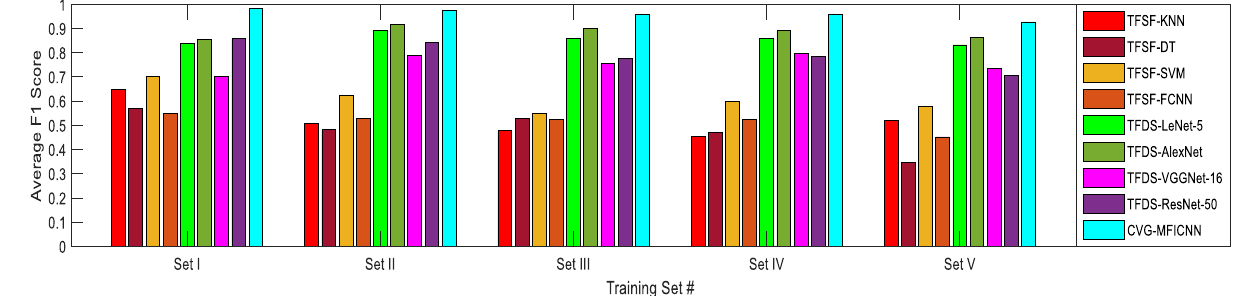
Figure 18. Comparison of average testing F1 scores of models trained using the proposed CVG- MFICNN method and existing methods based on different training sets.